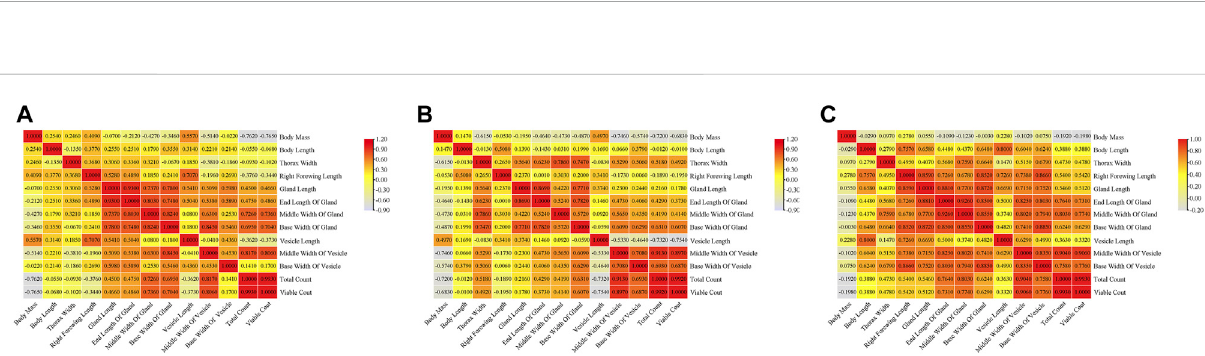
Developmental changes intotal sperm count and sperm viability with age indrones: (A) total sperm count; (B) discriminant analysis ofsperm count; (C) sperm viability; (D) discriminant analysis of sperm viability. MQD: drones from mated queens; VQD: drones from virgin queens; WBD: drones from worker